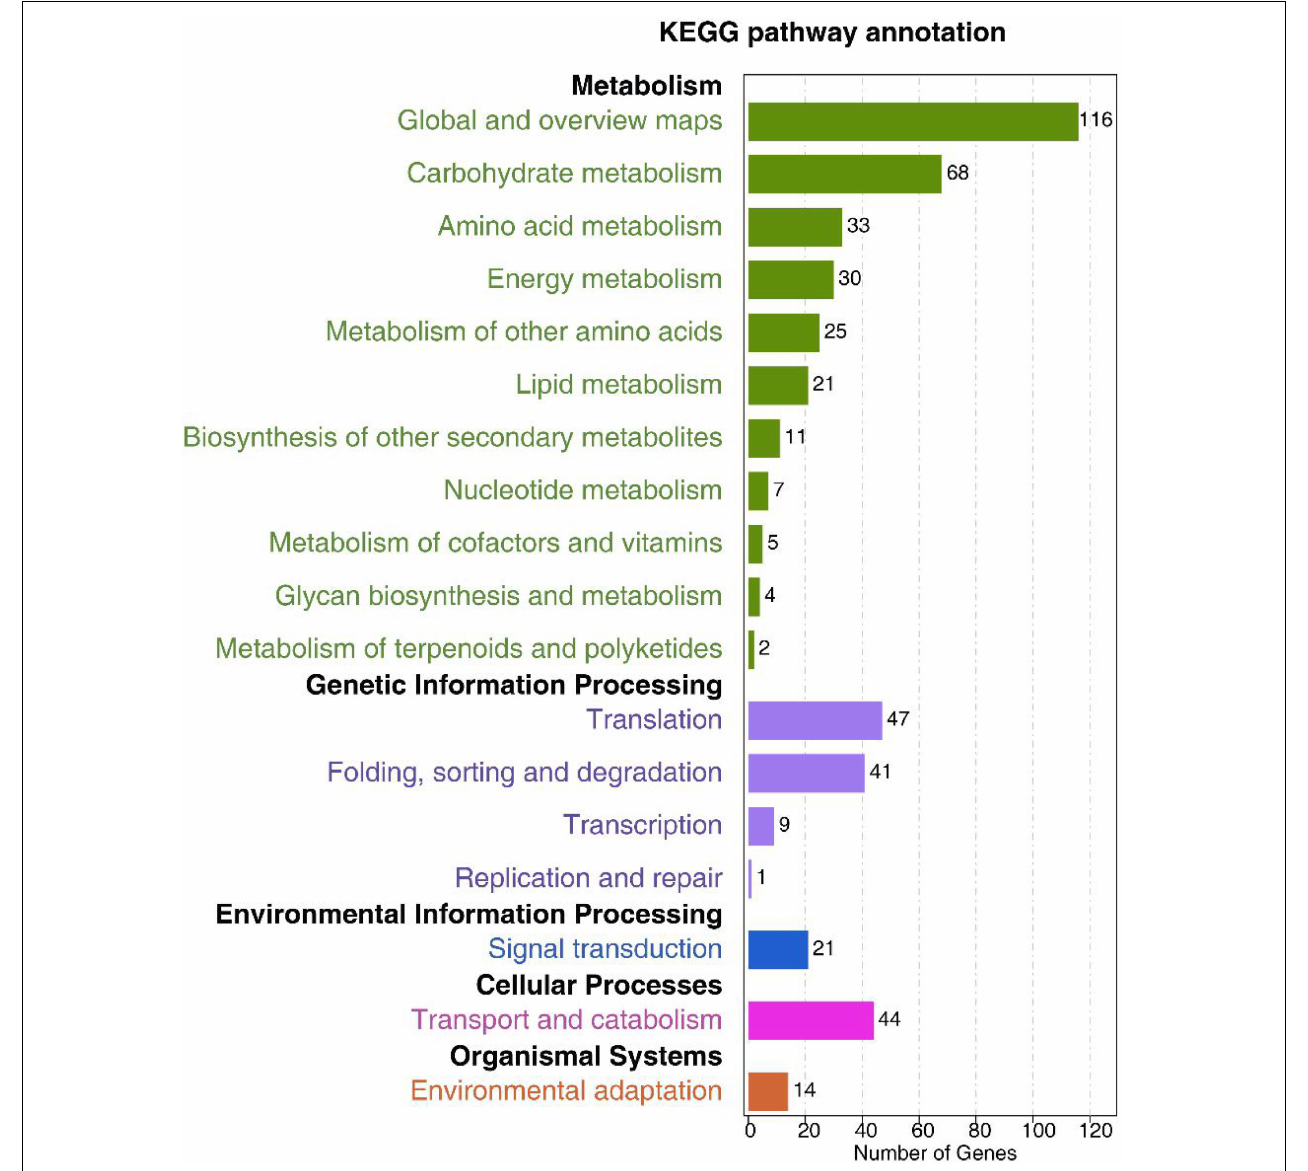
FIGURE 6 | Low-K + treatment-responsive differentially expressed miRNAs in terpenoid biosynthesis-related KEGG